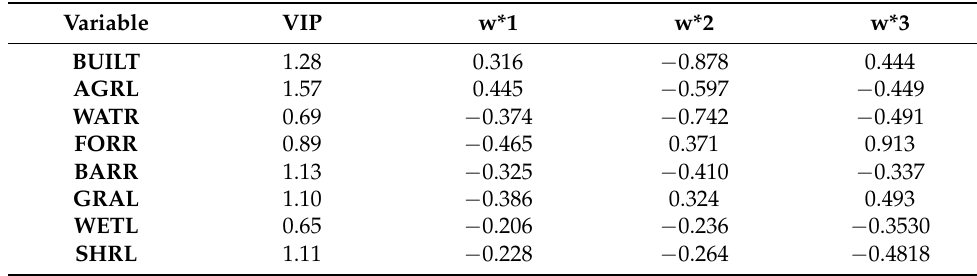
Table 7. Variable importance for the projection (VIP) values and PLSR weights for independent variables in the KWK